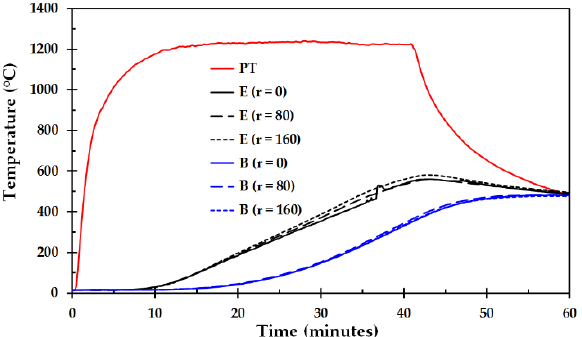
Figure 4. Temperature as a function of time for a representative test (6 mm thick steel plate thickness). Temperatures of the exposed and backing steel plates are marked E and B, respectively. The numbers indicate the radial thermocouple position (in mm). PT represents the plate thermometer.